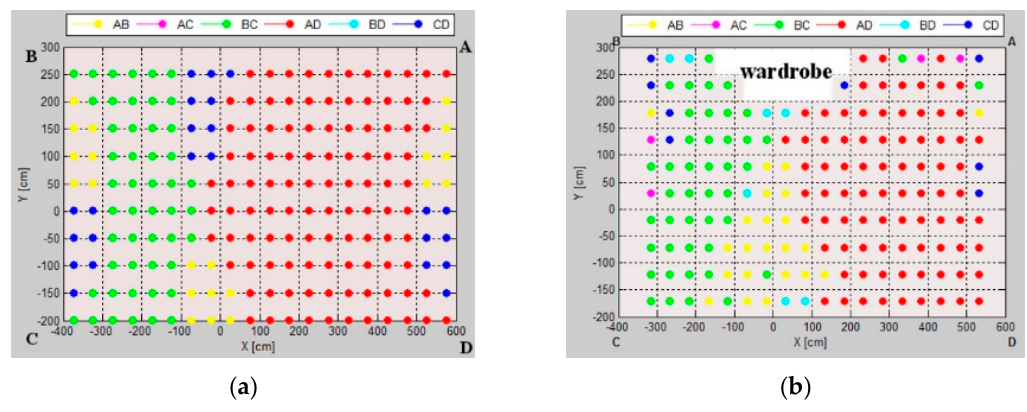
Figure 14. Uncertainty map from: (a) simulation; (b) physical experiment.